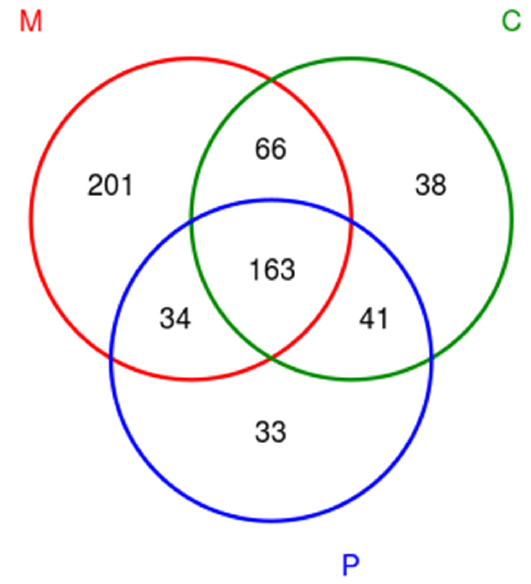
Figure 2. Venn diagram of OTU distribution. C is a sample of Cabernet Sauvignon, M is a sample of Matheran, and P is a sample of Cabernet Franc.